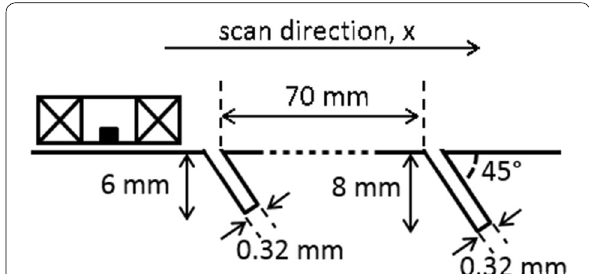
Figure 2 Simulated cracks of 45° inclination angle, with 6 mm and 8 mm depths